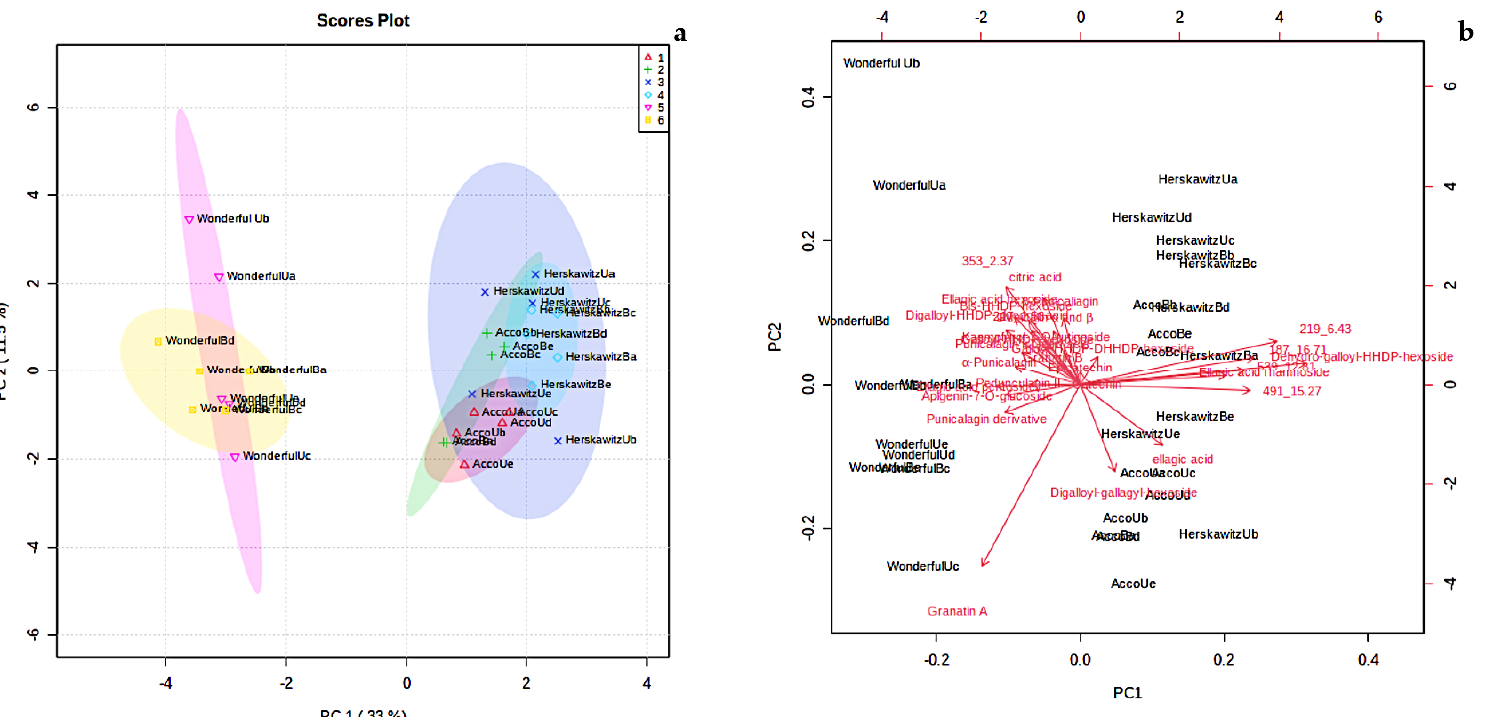
Figure 2. ( a ) Principal component analysis (PCA) score plot showing variation of P. granatum L. fruit peel from three different cultivars blanched at 80 °C for 3 min, i.e., ‘Acco’ unblanched (red colour), ‘Acco’ blanched (green colour), ‘Herskawitz’ unblanched (blue colour), ‘Herskawitz’ blanched (cyan colour), ‘Wonderful’ unblanched (purple colour), and ‘Wonderful’ blanched (yellow colour) peel extracts; ( b ) Principal component analysis (PCA) biplot showing the compounds that influenced the differentiation of collections into distinct clusters.